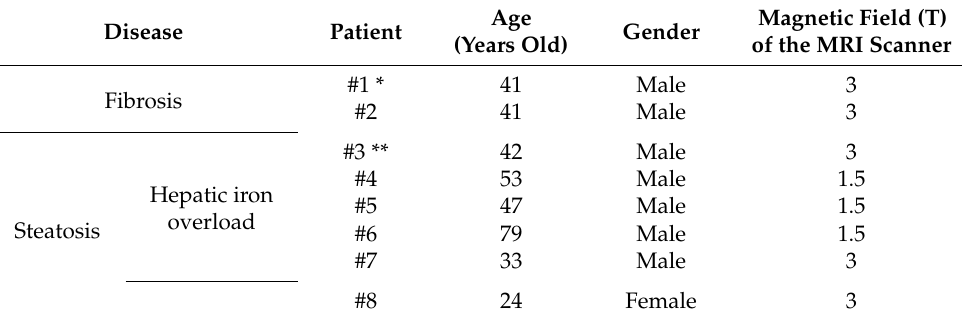
Table 1. Patient sample data for fibrosis, steatosis and hepatic iron overload. Magnetic Field (T) Age Gender Disease Patient of the MRI Scanner (Years Old) #1 * 41 Male 3 Fibrosis #2 41 Male 3 #3 ** 42 Male 3 #4 53 Male 1.5 Hepatic iron 1.5 overload Steatosis #7 33 Male #8 24 Female 3 In each disease, a healthy subject is considered as a reference for comparison with other subjects with different levels of the disease. * Control subject for fibrosis. ** Control subject for steatosis and hepatic iron overload.